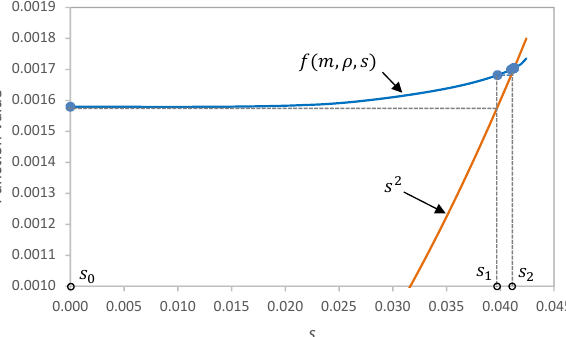
Figure 3. Performance of Algorithm-MVL for ( m , ρ ) = ( 0.93%,1.5 ) : optimal portfolio is obtained at iteration 4.